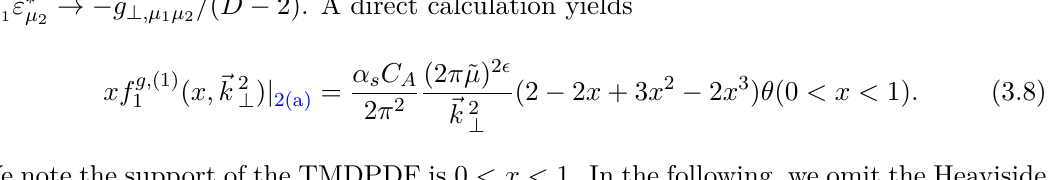
Figure 3 . One-loop Feynman diagrams for the gluon TMDPDFs with gauge link interactions. ε ε ∗ → − g / ( D − 2) . A direct calculation µ 1 ⊥ ,µ 1 µ 2 µ 2